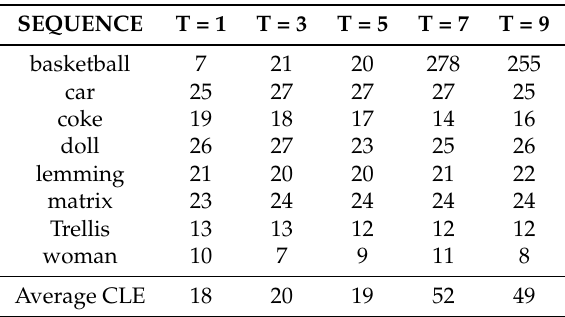
Table 3. The parameter setting